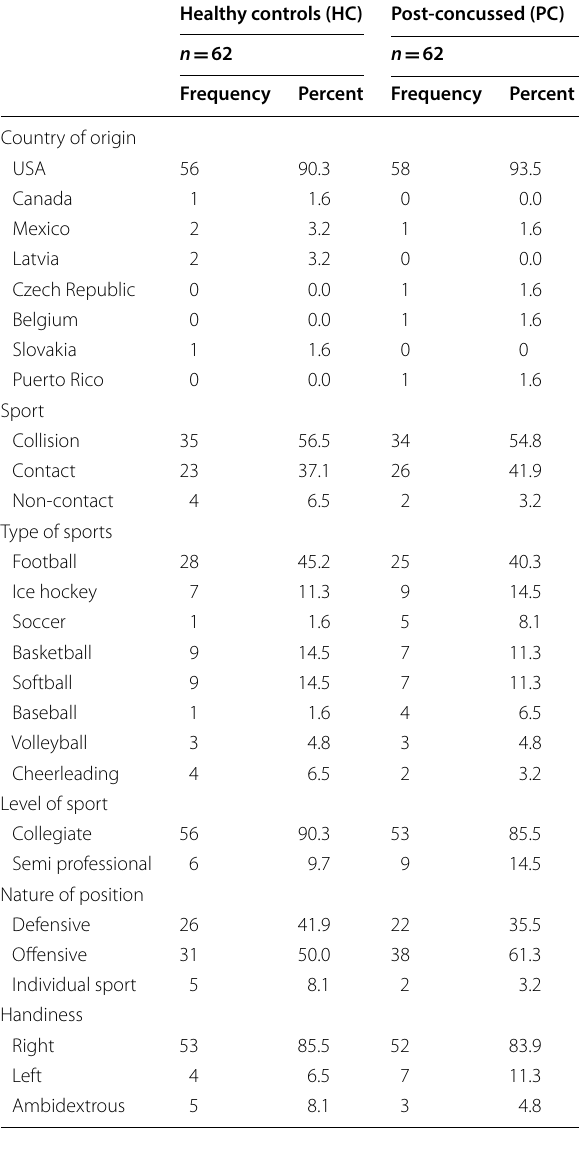
Table 3 Demographic of the healthy controls and